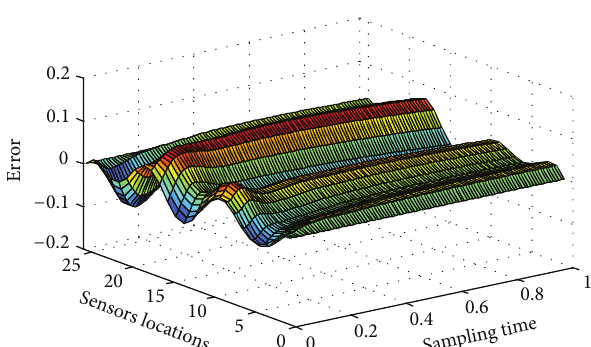
Figure 4: Predicted error based on 3 optimal combined